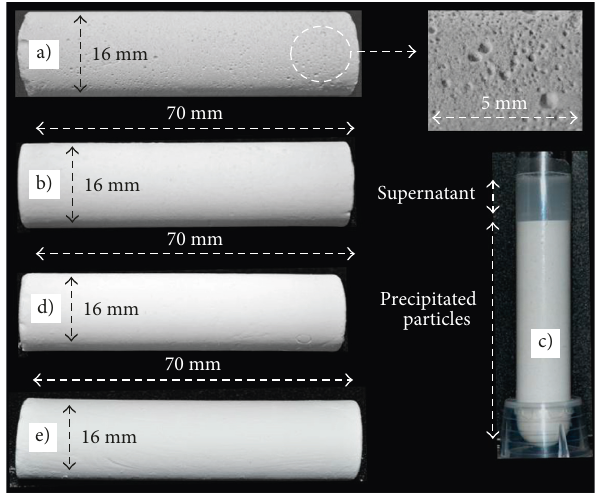
Figure 7: Samples mixed and cured in the conventional static way containing (a) 25 vol.%, (b) 50 vol.%, and (c) 80 vol.% of water (tube containing sedimented suspension); (d) sample containing 80 vol.% of water after curing under rotation; (e) sample containing 25 vol.% of water cast under isostatic